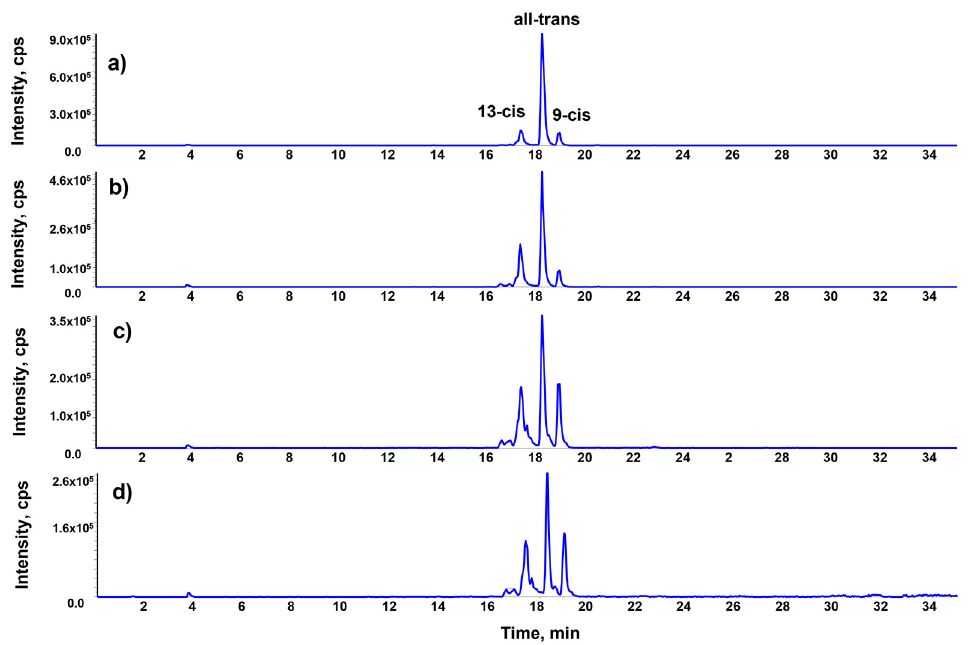
Figure 3. LC-MRM profiles of β -carotene in pepper: raw ( a ), cooked with electric oven ( b ), cooked with solar oven ( c ), cooked with UV filtered solar oven ( d ). y axis values are expressed as counts per second (cps).